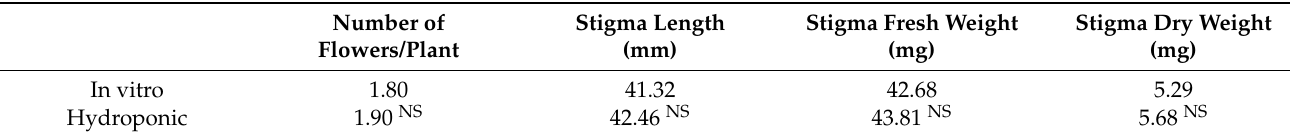
Table 1. Comparison of stigma and flower size of saffron produced under in vitro culture and via a hydroponic system (Dewir and Alsadon [16]).